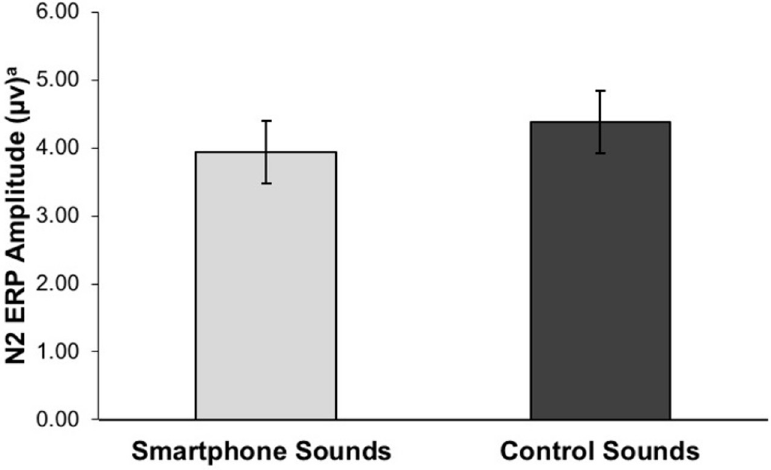
Fig 5. N2 amplitude on smartphone and control sound trials. N2 ERP mean amplitudes on trials with smartphone and control sounds. a N2 is a negative going potential, thus smaller values indicate larger ERP amplitudes.